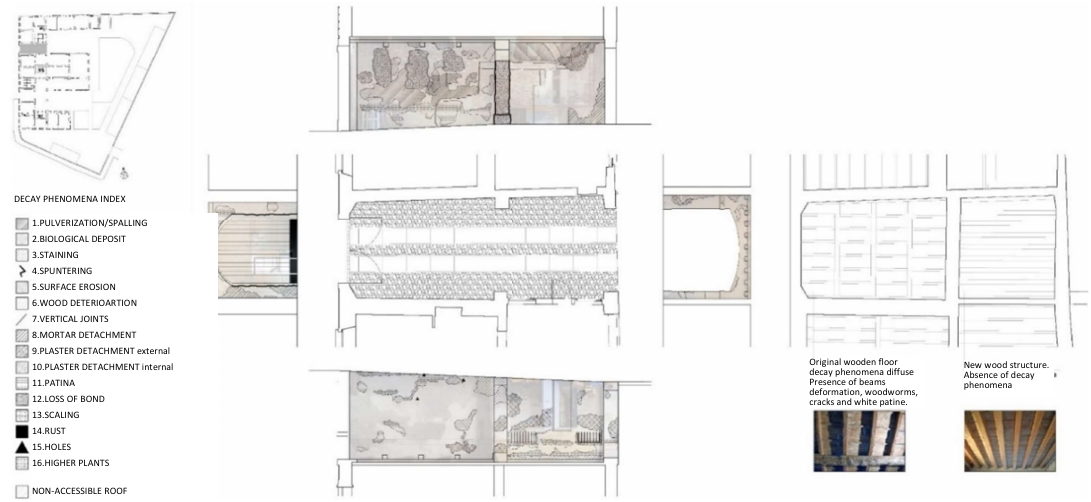
Figure 6. Crack pattern representation for each room of the building.